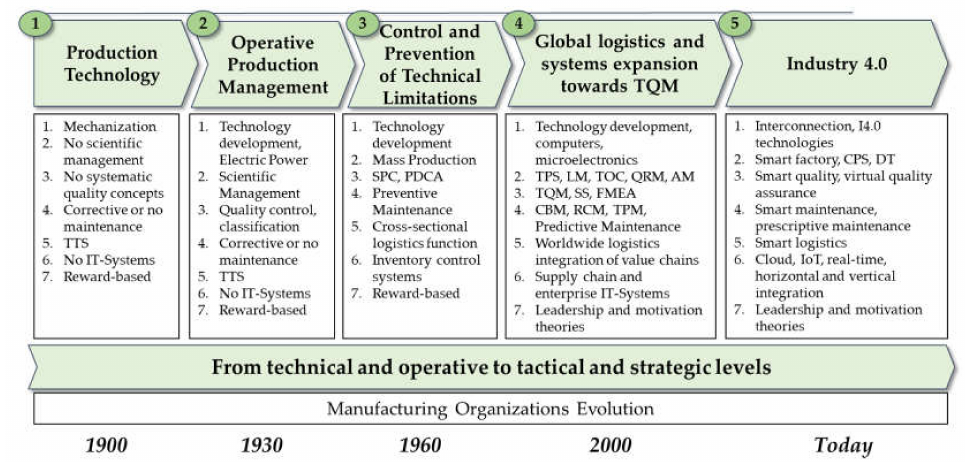
Figure 3. Manufacturing Function Development Phases and their characteristics (the authors’ own